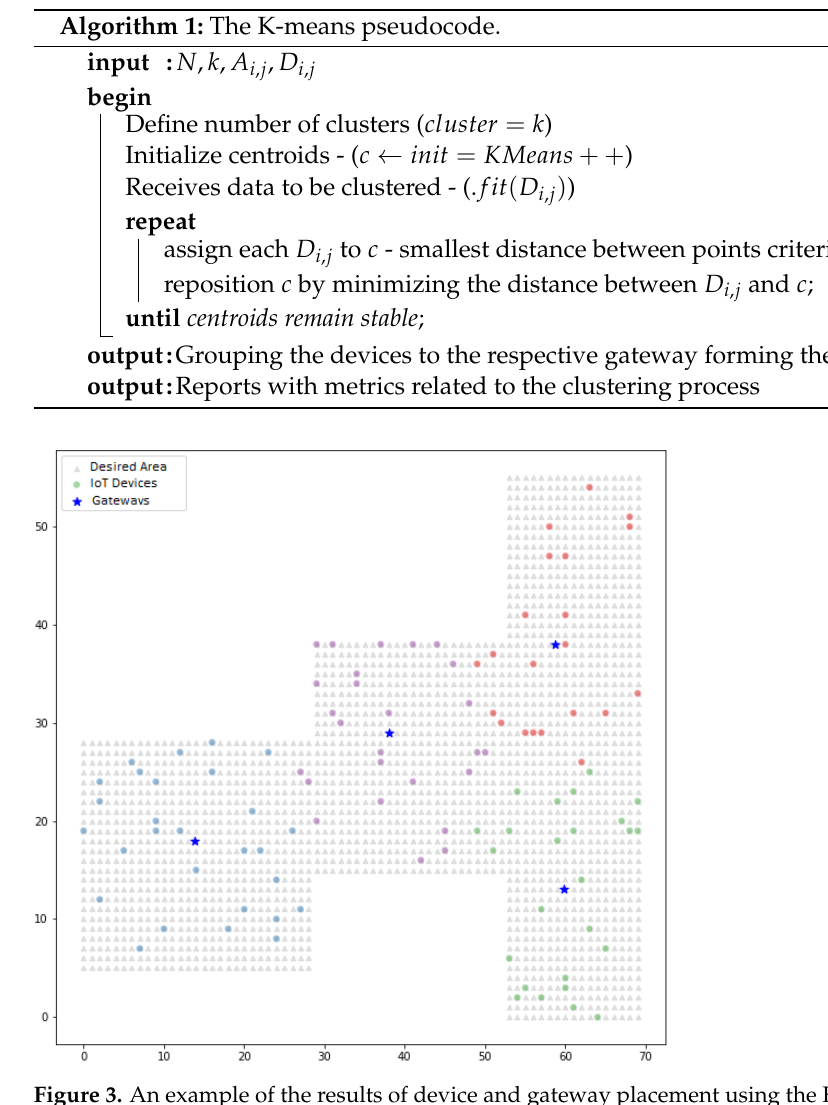
Figure 3. An example of the results of device and gateway placement using the K-means